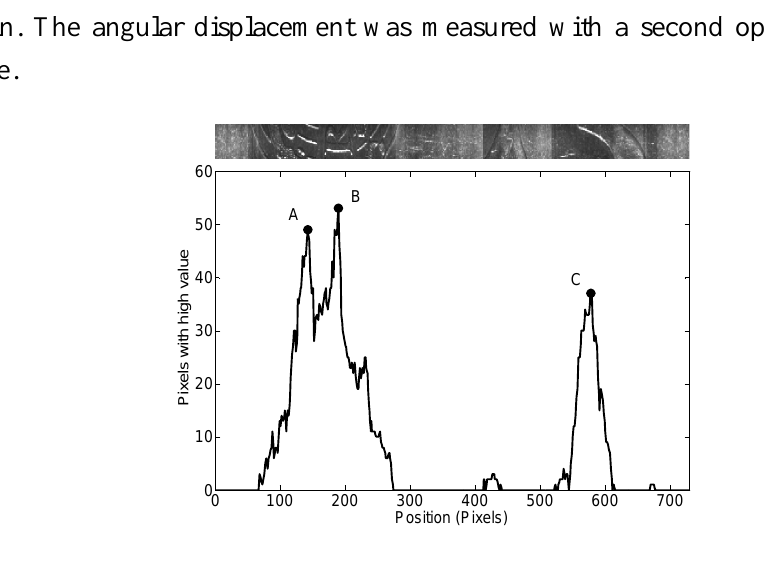
Figure 12. A (left), B (middle), and C (right) reference images selected as